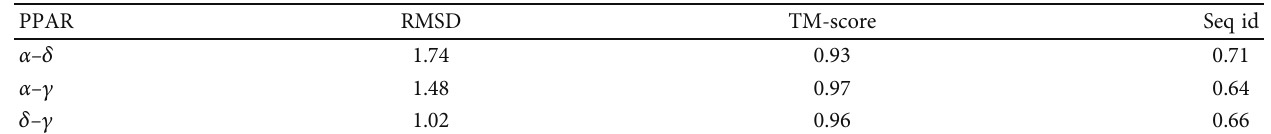
Table 1: Structural comparison of PPARs. Root mean square deviation [Å], protein fold similarity, and sequence identity [%]. All metrics evaluated with the TM-align tool